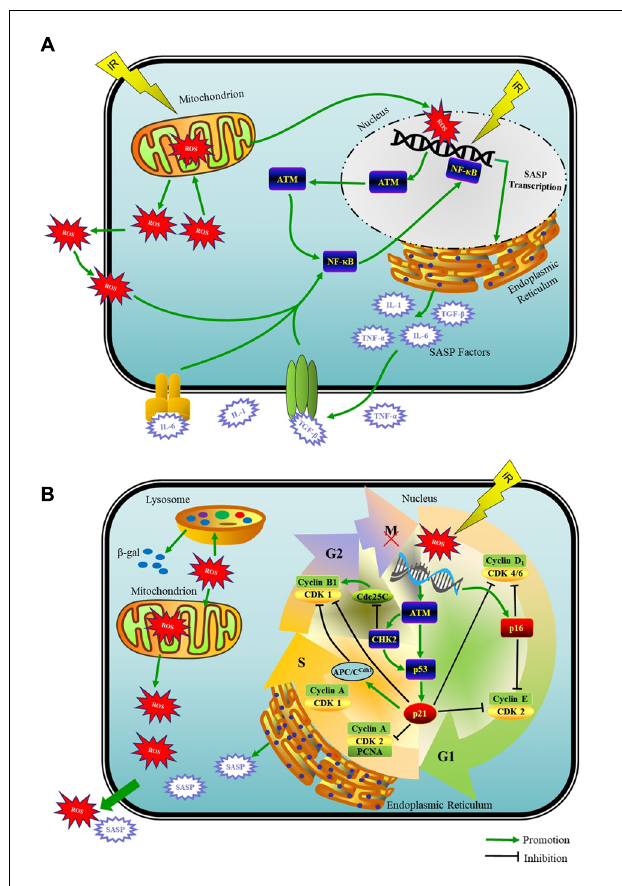
FIGURE 1 | Schematic model of the DDR that induces a mitosis bypass and cellular senescence in response to IR. (A) When irreparable DNA damage initiates, cell cycle can get interrupted by G2 arrest for long time, which is followed by mitotic bypass into G1 phase with replicated DNA and culminates in cellular senescence. ATM- p53- p21, ROS produced by mitochondria, SASP factors and cyclin-CDK complexes are pivots of this senescence progress. (B) The recruitment of ATM to DSBs activates the NF- κ B signaling that induces SASP expression including IL-1 α / β , IL-6, TGF- β , and TNF- α et al. With potent autocrine and paracrine activities, SASP factors are co-opted to affect surrounding